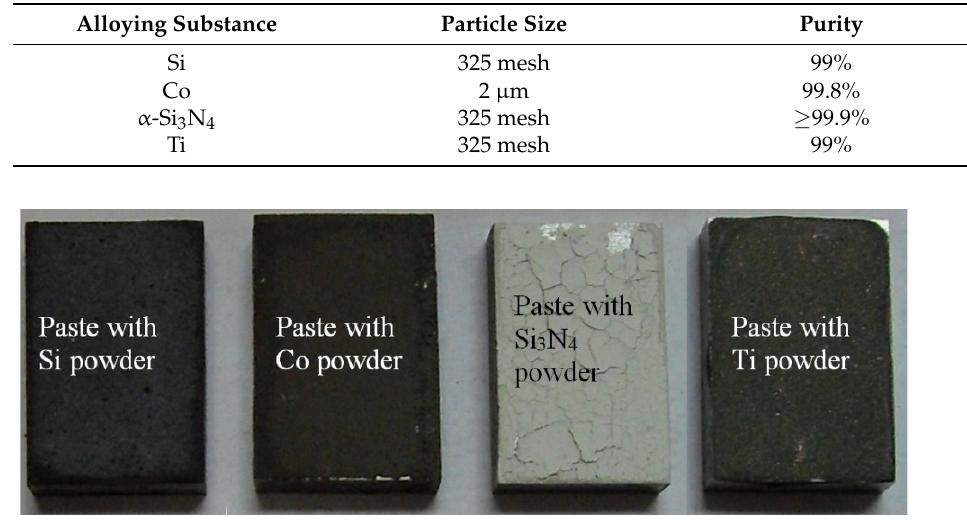
Figure 1. Samples of nodular iron covered with individual